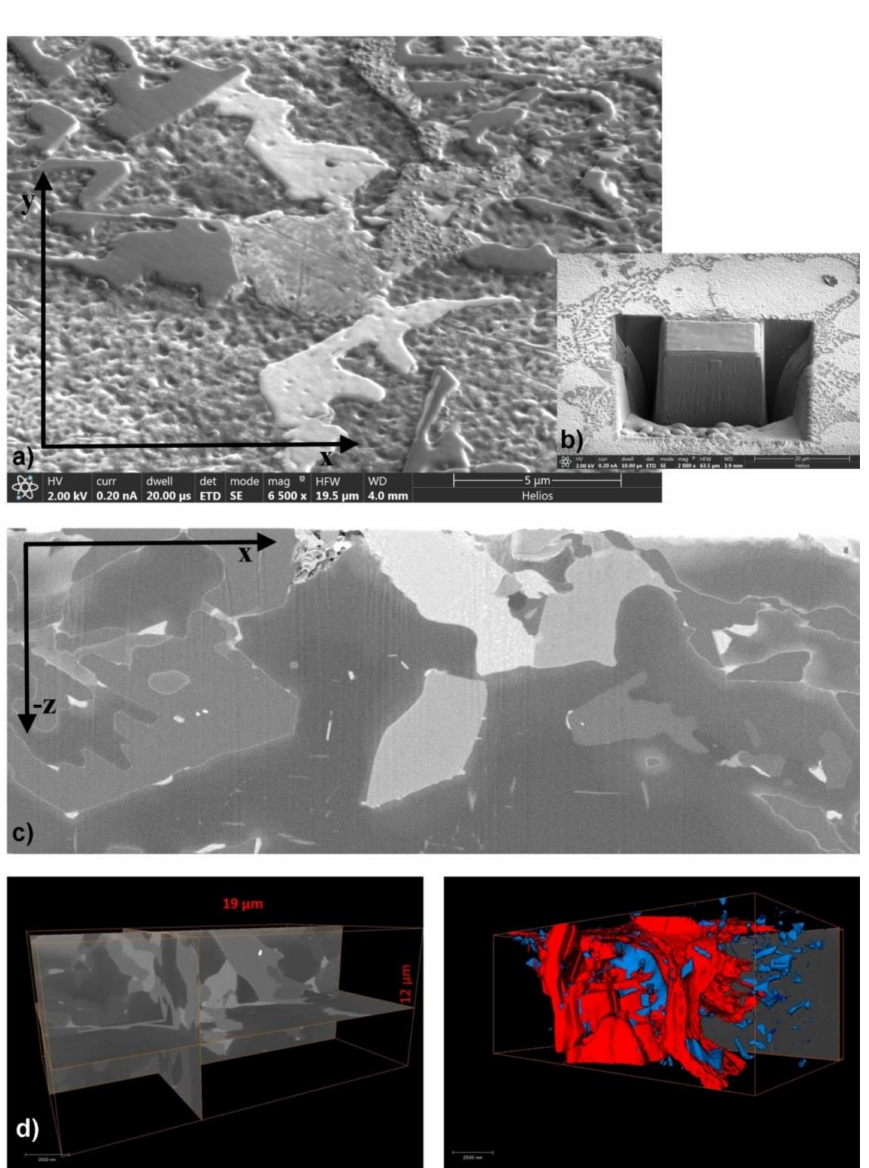
Figure 5. Focused ion beam scanning electron microscopes (FIB / SEM) tomography of AlSi7MgCu alloy: ( a ) SE image of the surface, ( b ) SE image of the trench prior to FIB / SEM, ( c ) orthoslice example of the x-(-z) imaging plane, ( d ) 3D distribution and shape of the Al-Si-Mg-Cu (red) and Al-(Fe-Mn-Cu)-Si (blue). Animation is available as a Supplementary Material Video